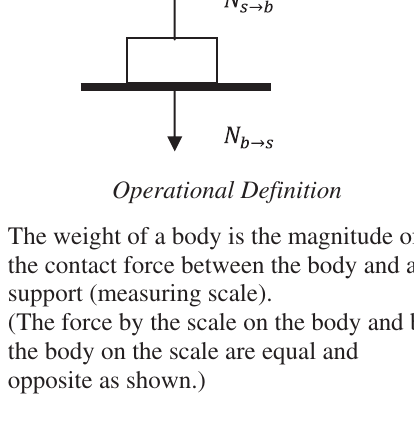
FIG. 1. Alternative definitions of